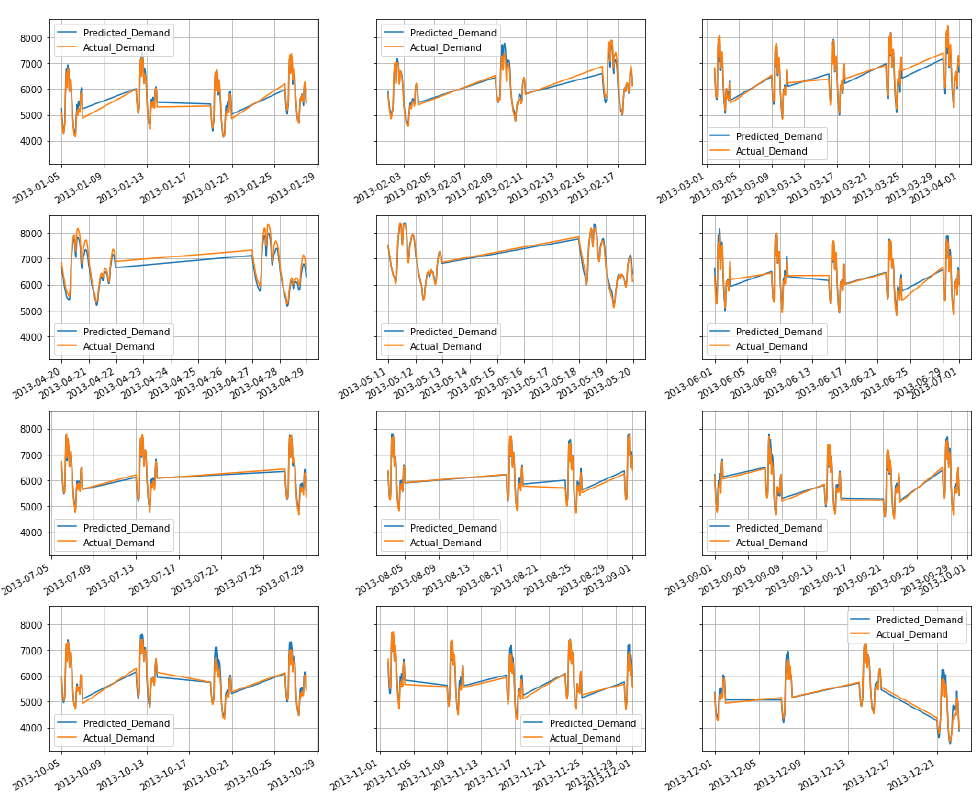
Figure A2. Forecasting performance of the VR model (Group